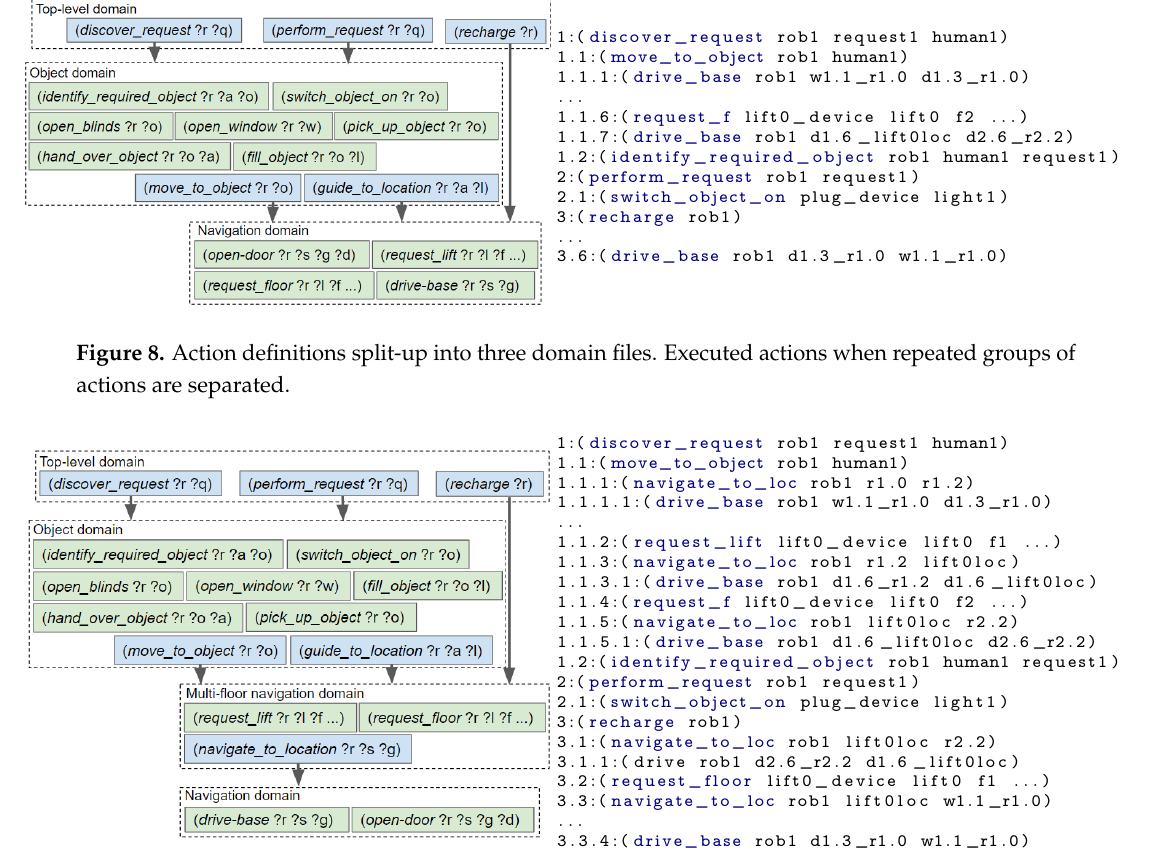
Figure 9. Domain files and executed actions for when we have split-up knowledge about what floor the robot is on. The fully hierarchical